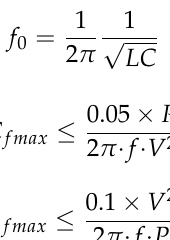
Table 5. The LCL filter elements.